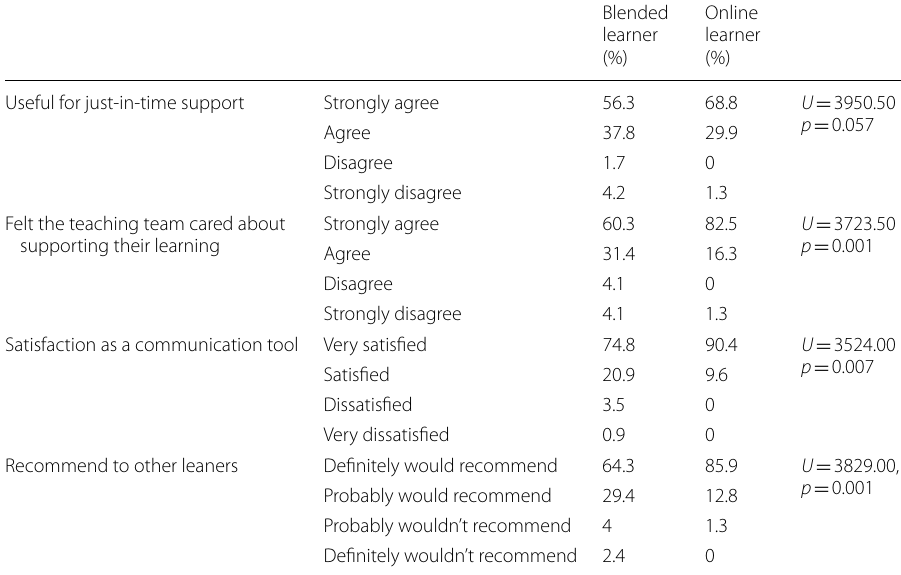
Table 1 Online and Blended learners use of live chat: satisfaction, just-in-time support, care and support, and recommend to others